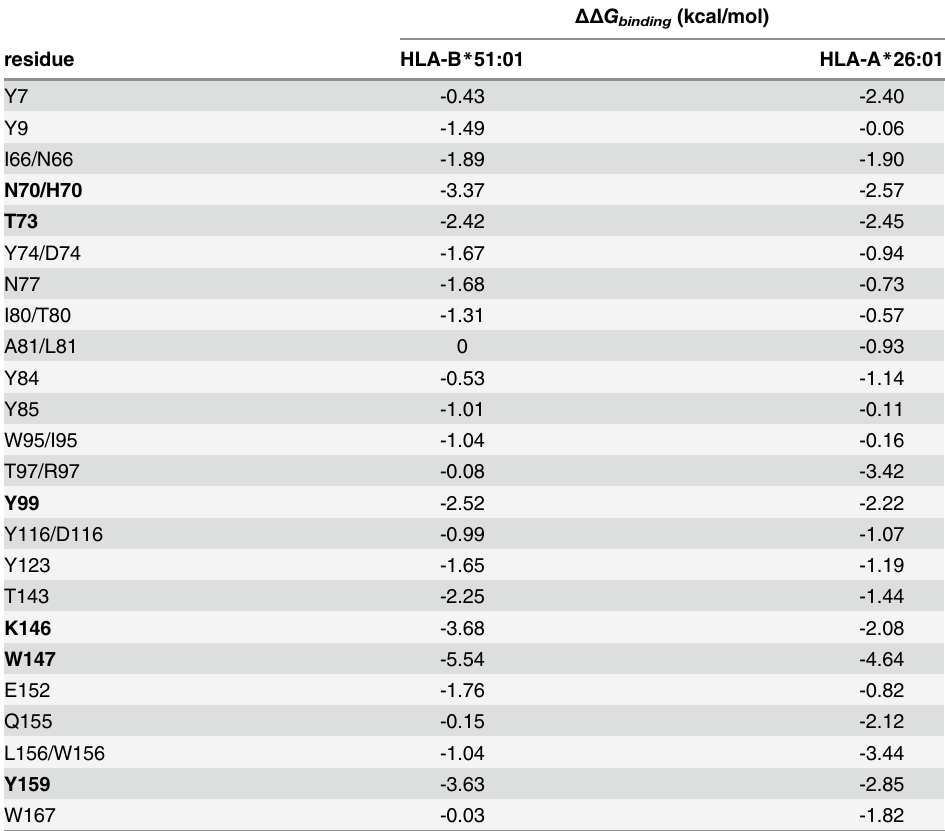
Table 2. Relative binding free energy upon alanine mutation ( ΔΔ G binding ) for the HLA residues within 5 Å sphere of the MICA peptide. The residues with ΔΔ G shown in bold